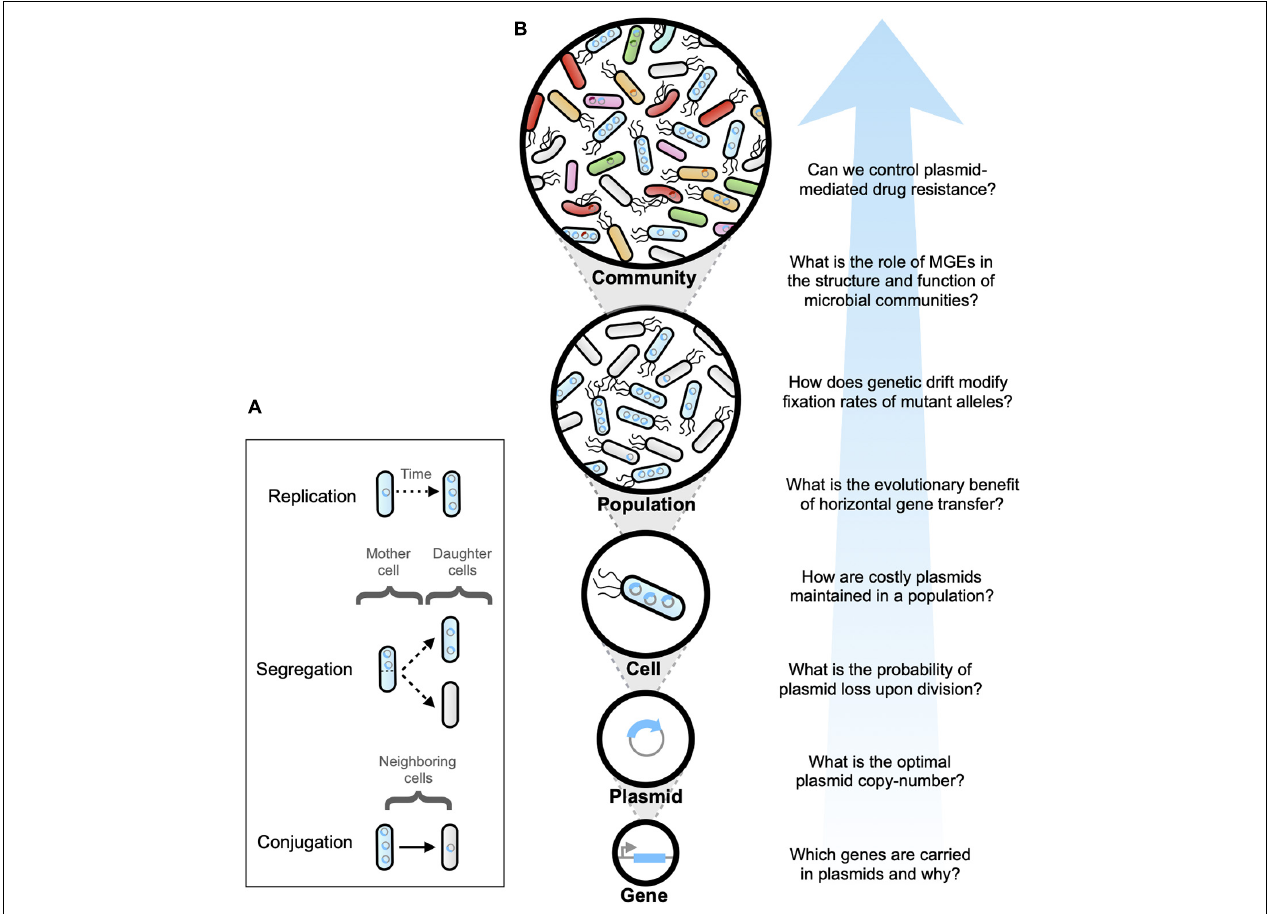
FIGURE 1 | (A) Plasmid dynamics emerges as a result of the complex interaction between plasmid replication and copy-number control (occurring inside individual cells), plasmid segregation (from mother to daughter cells), and plasmid conjugation (between neighboring cells). (B) Schematic diagram illustrating multiple complexity levels involved in plasmid life cycle. Each complexity level yields important questions that have been addressed using mathematical modeling and computer